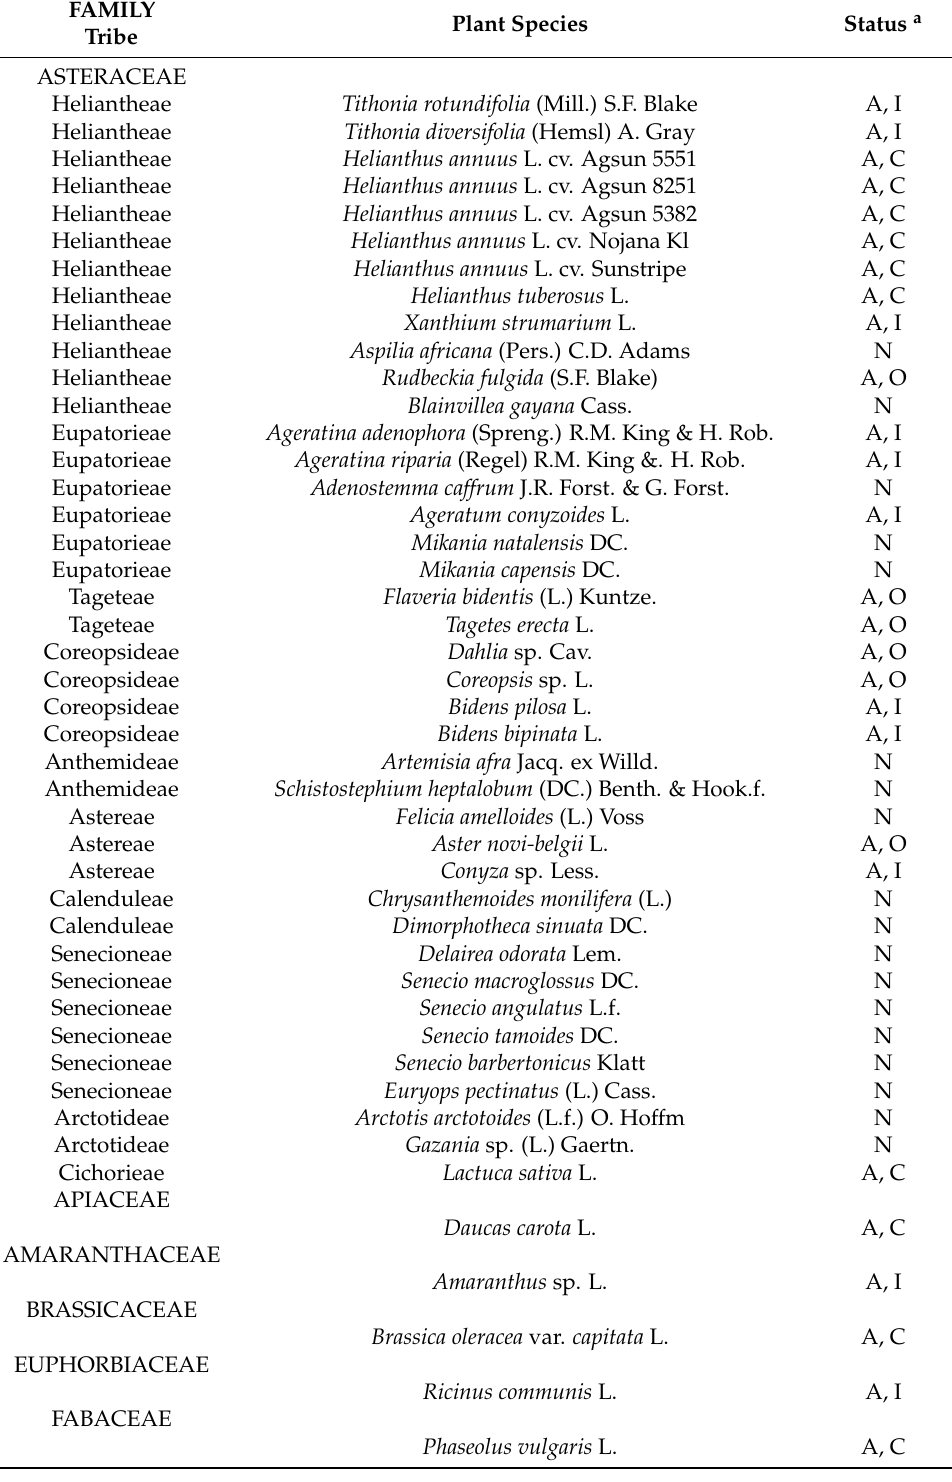
Table 1. List of test-plant species that were used during host-specificity tests on Zygogramma signatipennis and Zygogramma piceicollis